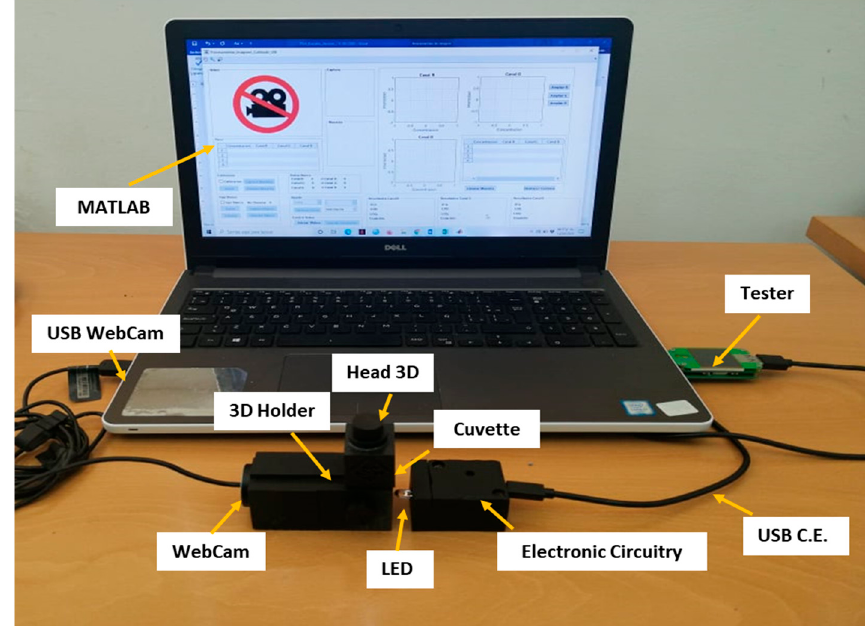
Figure 4. Real proposed system used for colorimetric and fluorometric measurements.